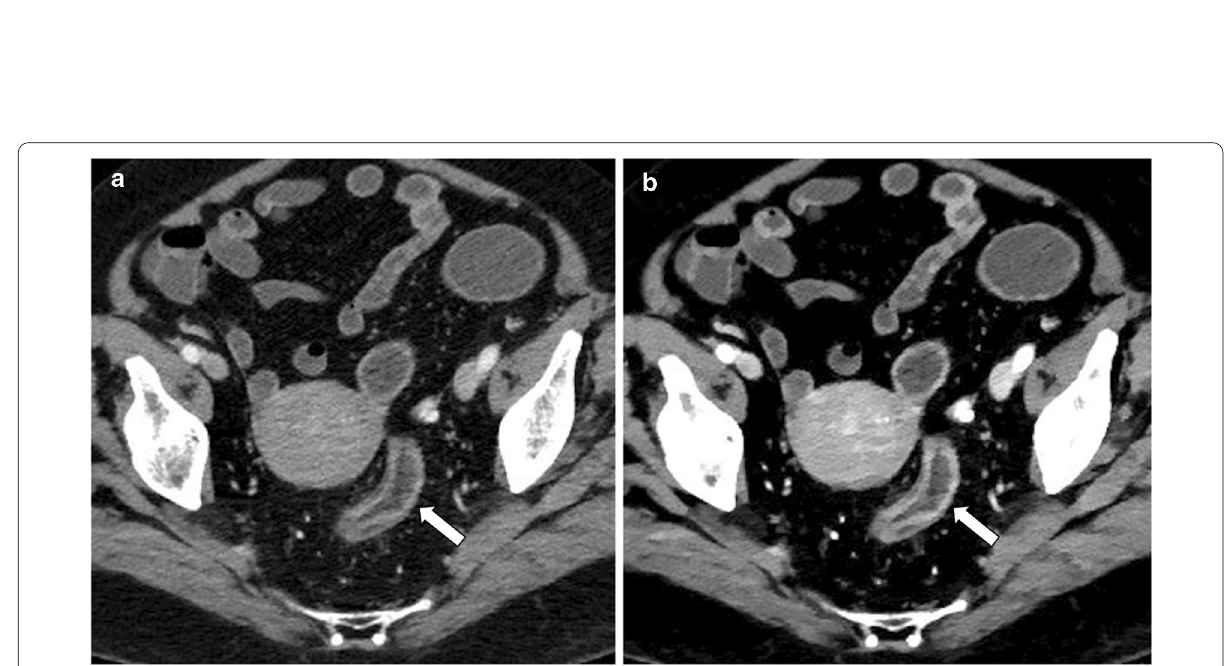
Fig. 11 CT enterography of a 74-year-old woman with known Crohn’s disease of the colon. Conventional images show mild mucosal hyperenhancement in the sigmoid colon ( a ) which is more conspicuous using 50 keV mono-energetic images ( b